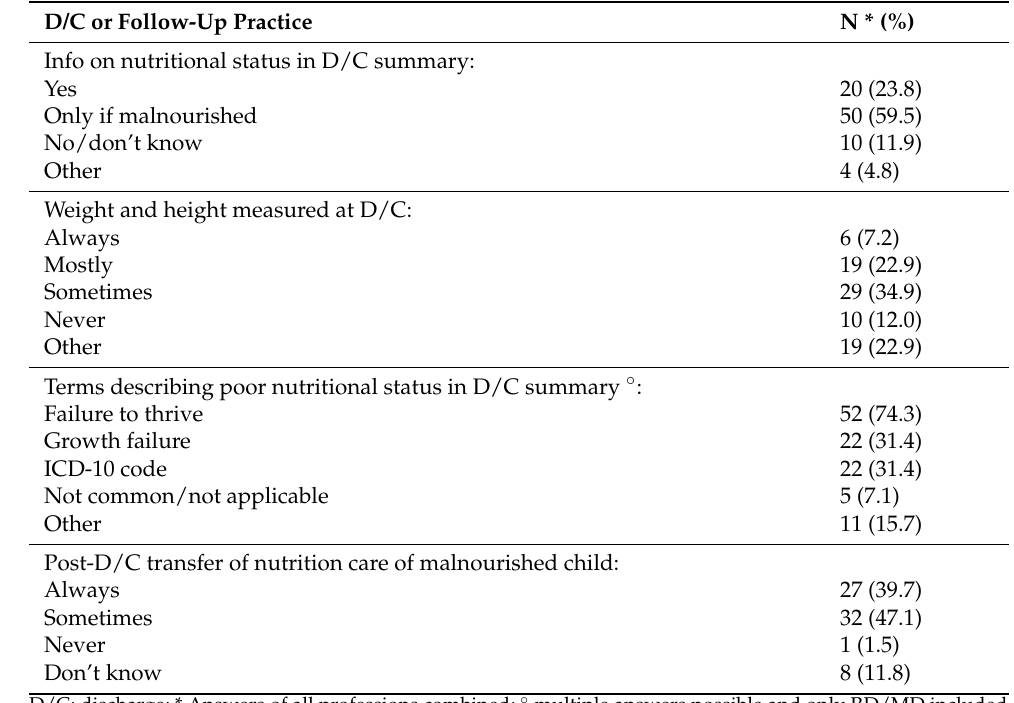
Table 1. Nutrition discharge and follow-up practices in Canadian tertiary pediatric